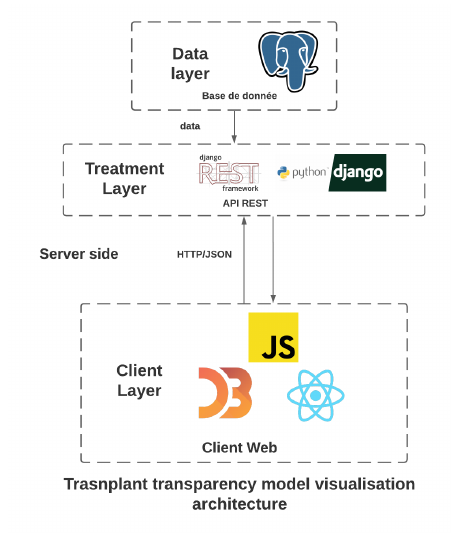
Figure 9. Technical architecture of the